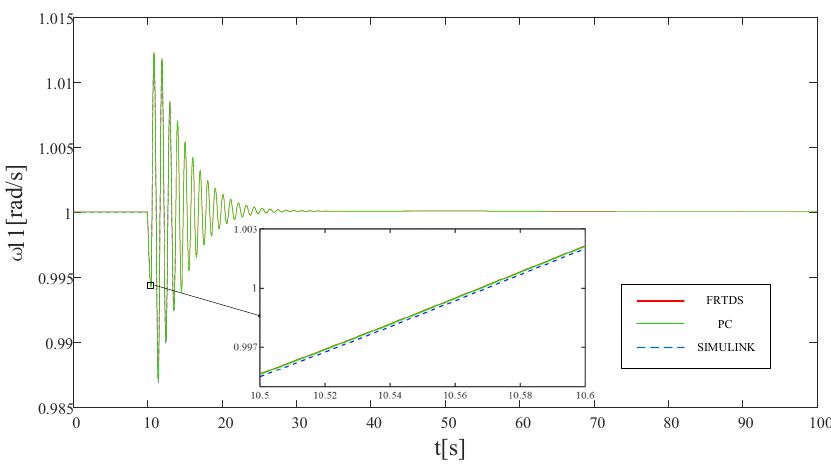
Figure 10. The rotor angular velocity of the generator connected to bus 11.